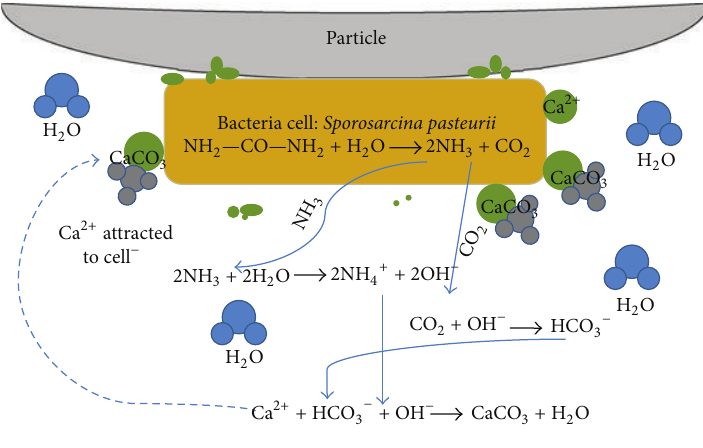
Figure 2: Process of producing calcium carbonate [6].